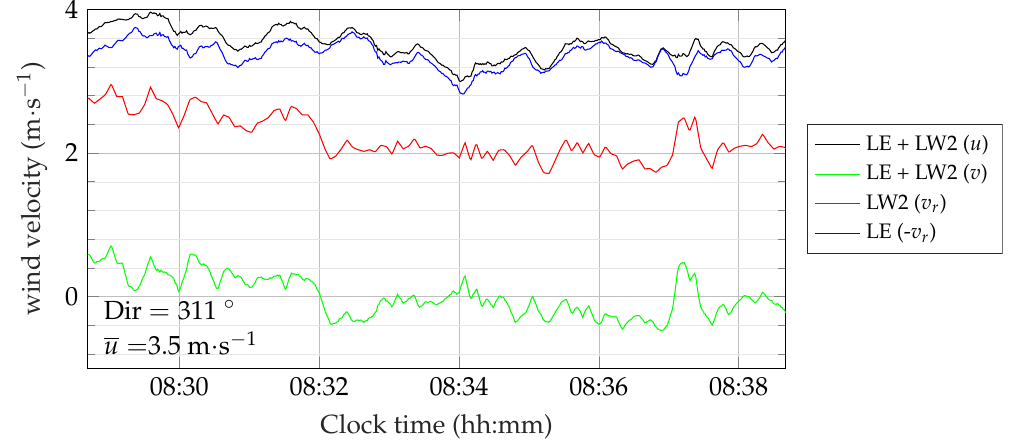
Figure 3. Along-beam velocity component recorded by the Lidar West 2 and the Lidar East on 2016-06-07 (East-West configuration), and corresponding retrieved horizontal wind